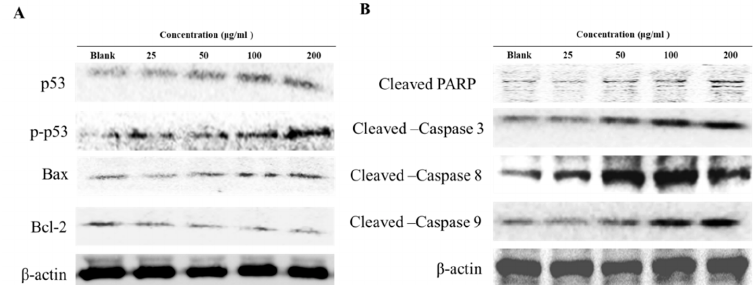
Figure 4. Effects of DCMF on the Bcl-2 family and p53 ( A ) and caspase family ( B ) protein expression in HepG2 cells. HepG2 were treated with the indicated concentrations of DCMF for 24 h. The equal amounts of cellular proteins were probed with the indicated antibodies, and the proteins were visualized using an ECL detection system. Actin was used as an internal control.